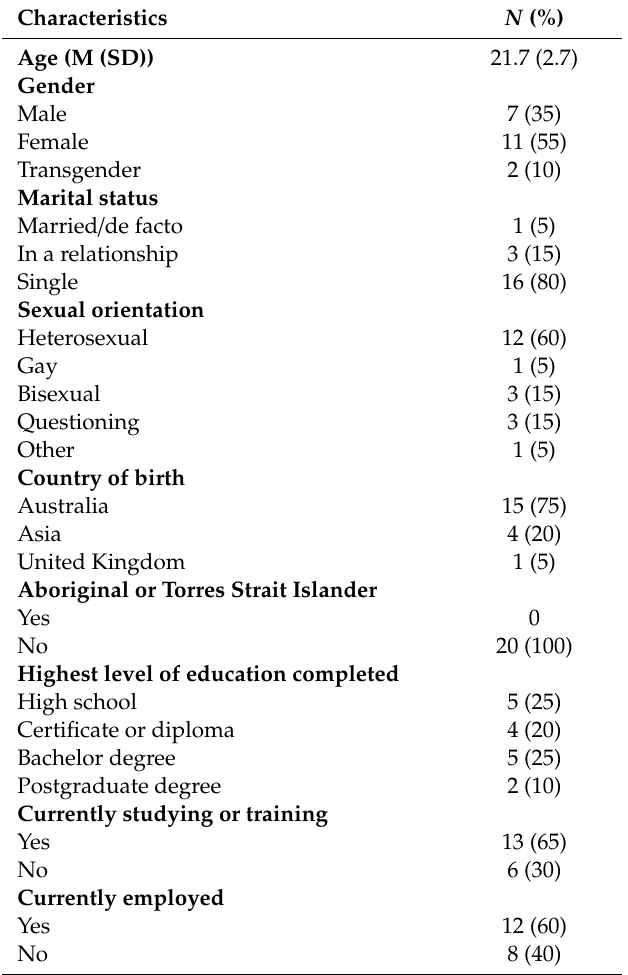
Table 1. Demographic characteristics of the